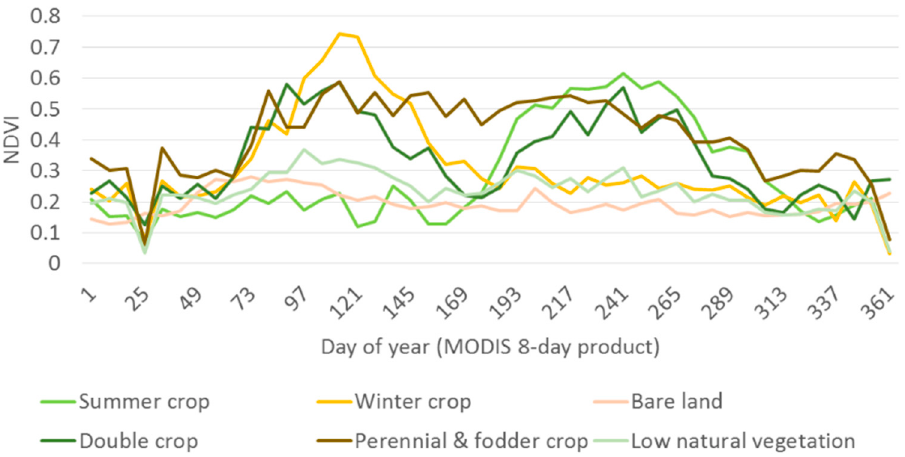
Figure 7. MODIS-NDVI time series of the six CVP classes, exemplarily shown for selected pixels of 2007.